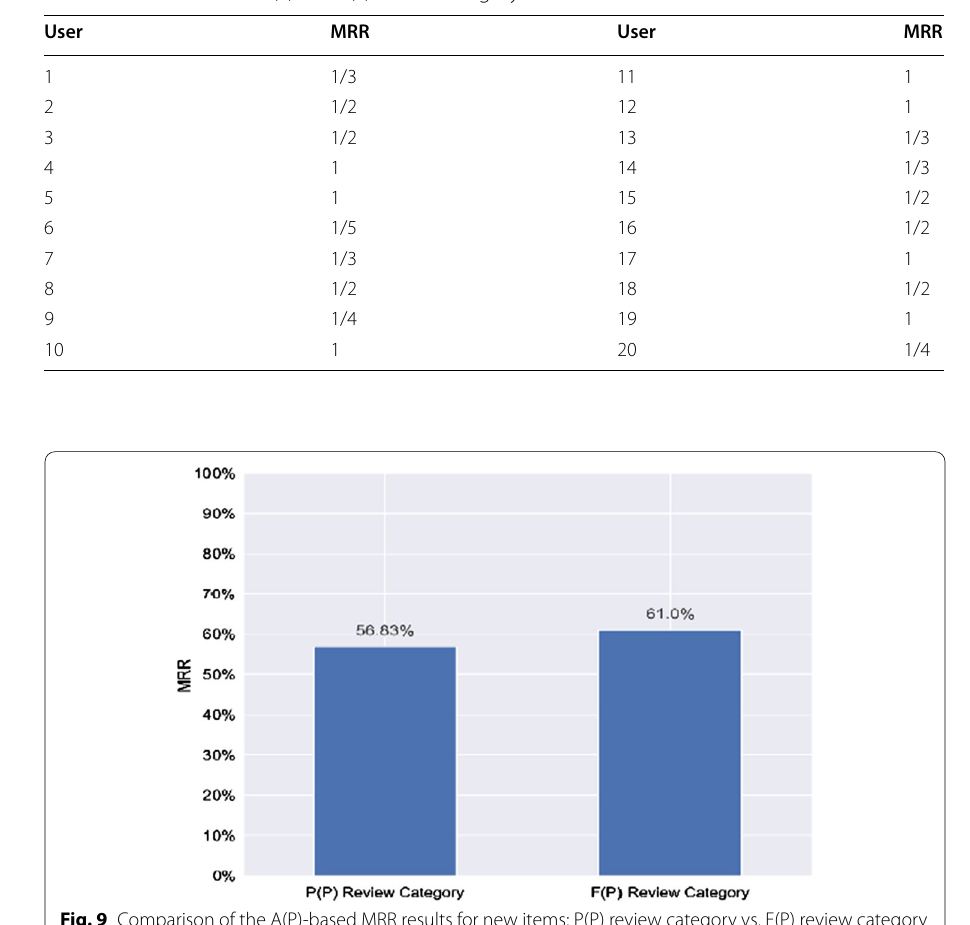
Table 9 MRR based on A ( P ) and F ( P ) review category